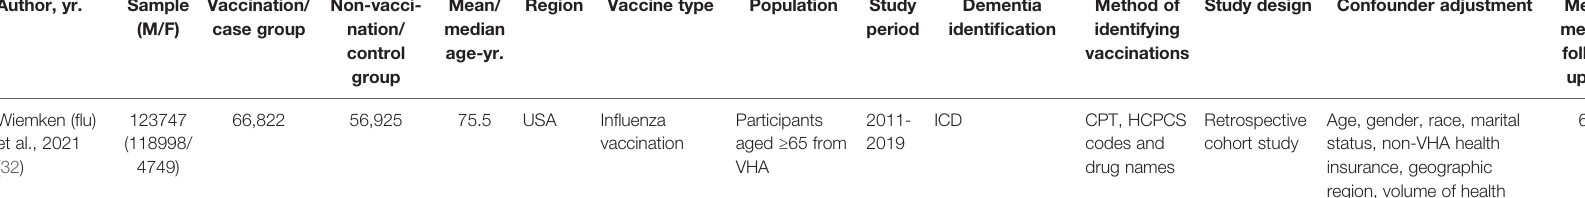
TABLE 1 | Main characteristics of the included studies. Author,